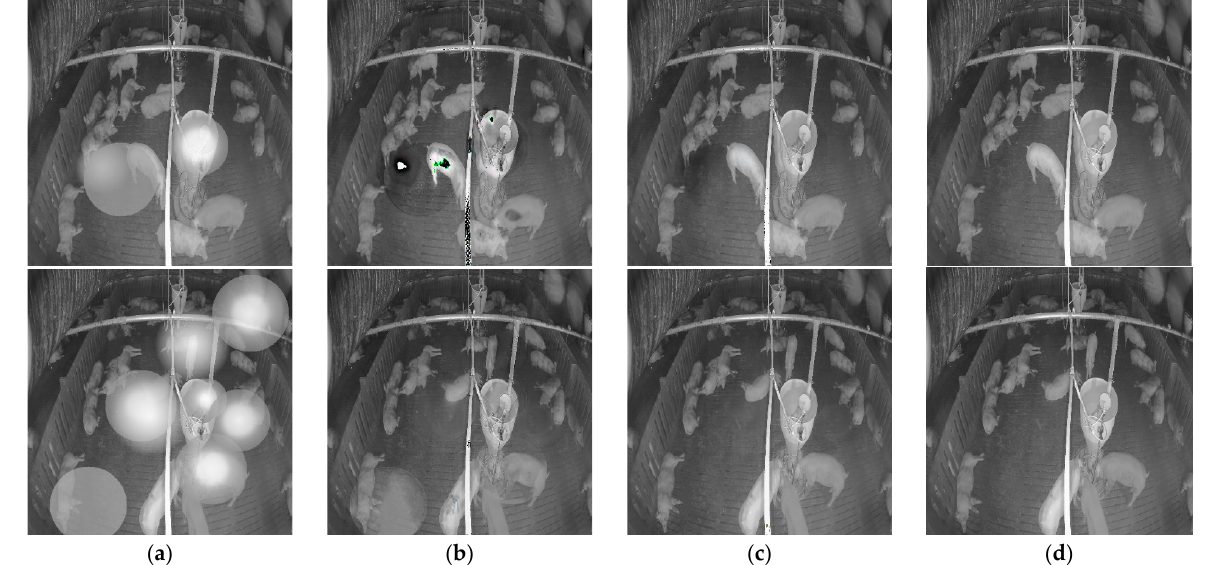
Figure 10. Denoised image produced by the model with and without the attention module on the simulated noisy image: ( a ) simulated noisy image; ( b ) denoised image without attention module; ( c ) denoised image with attention module; ( d ) Clean image.